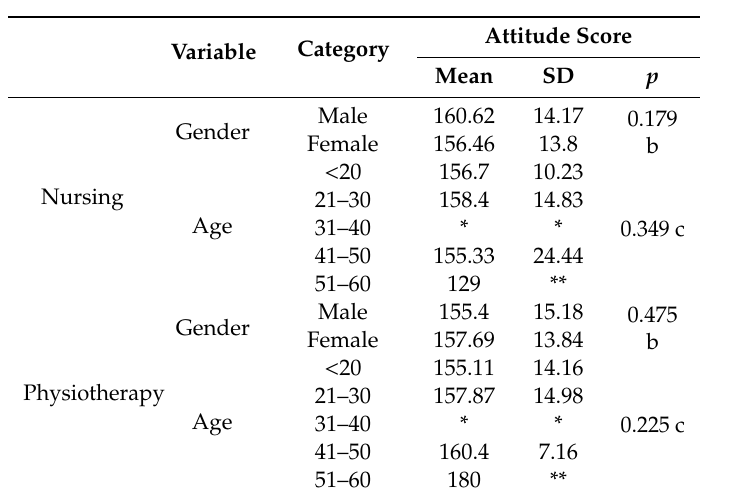
Table 3. Di ff erence of attitudes according to gender and age in the nursing and physiotherapy bachelor´s degrees.